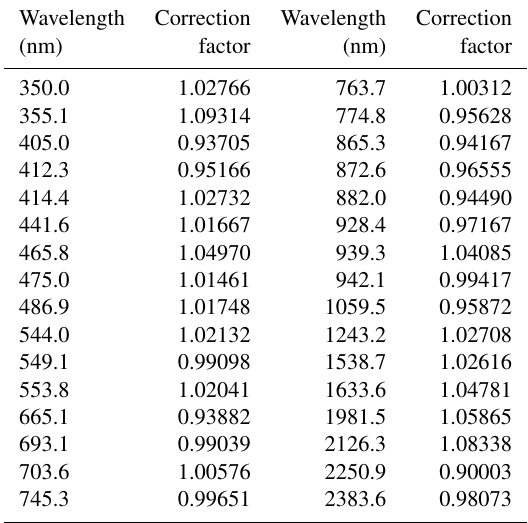
Table A1. Coefficients for smoothing at the ROLO 32